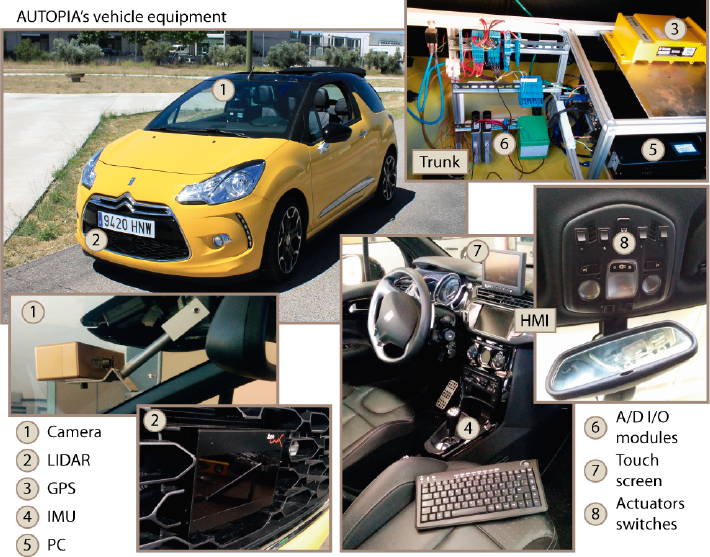
Figure 7. Automated vehicle architecture.